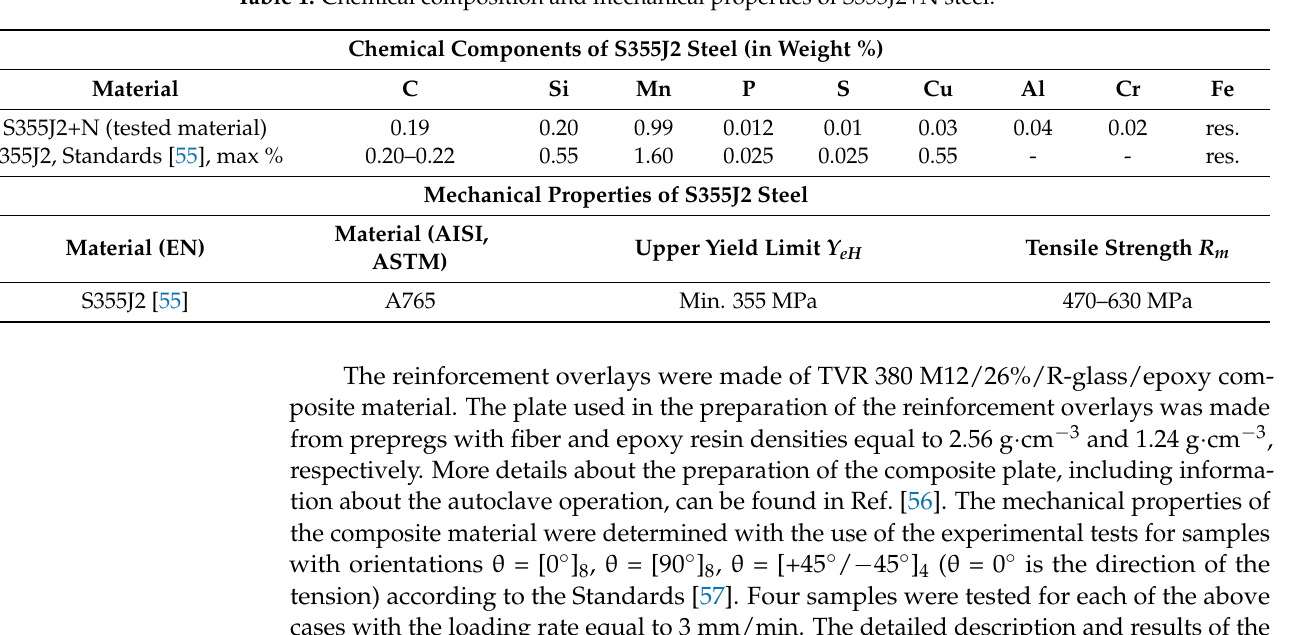
Table 1. Chemical composition and mechanical properties of S355J2+N steel.